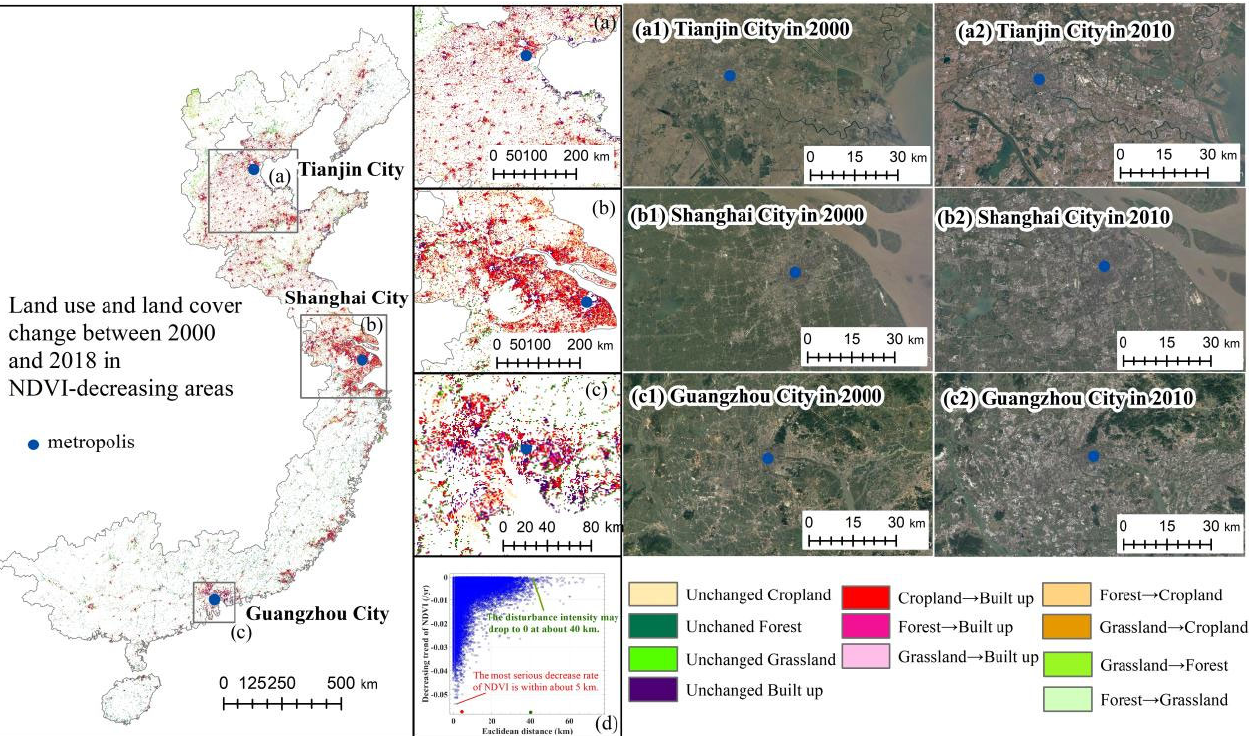
Figure 5. Land-use and land-cover change between 2000 and 2018 in NDVI-decreasing areas. In ( d ), P1 indicates the disturbance intensity may drop to 0 at about 40 km; P2 indicated the most drastic reduction rate of NDVI is within about 5